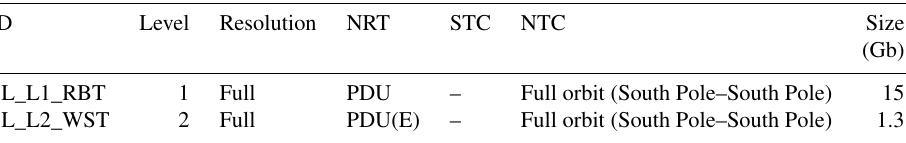
Table 4. Sea surface temperature user data products (SLSTR). All products are available from the monthly online rolling archive (ODA) and the long-term archive (DC) (see Sect. 3). EUMETCast dissemination is indicated by (E). Granularity: the products are provided as 3min product data units (PDUs). The sizes are given for a full orbit and are an approximation based on compression assumptions and may slightly vary.